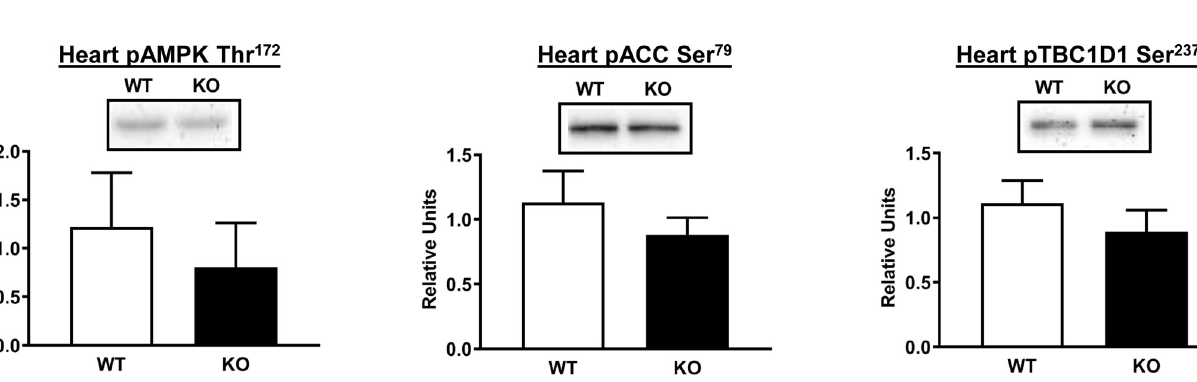
PLOS ONE | https://doi.org/10.1371/journal.pone.0223340 February 13, 2020 15 /